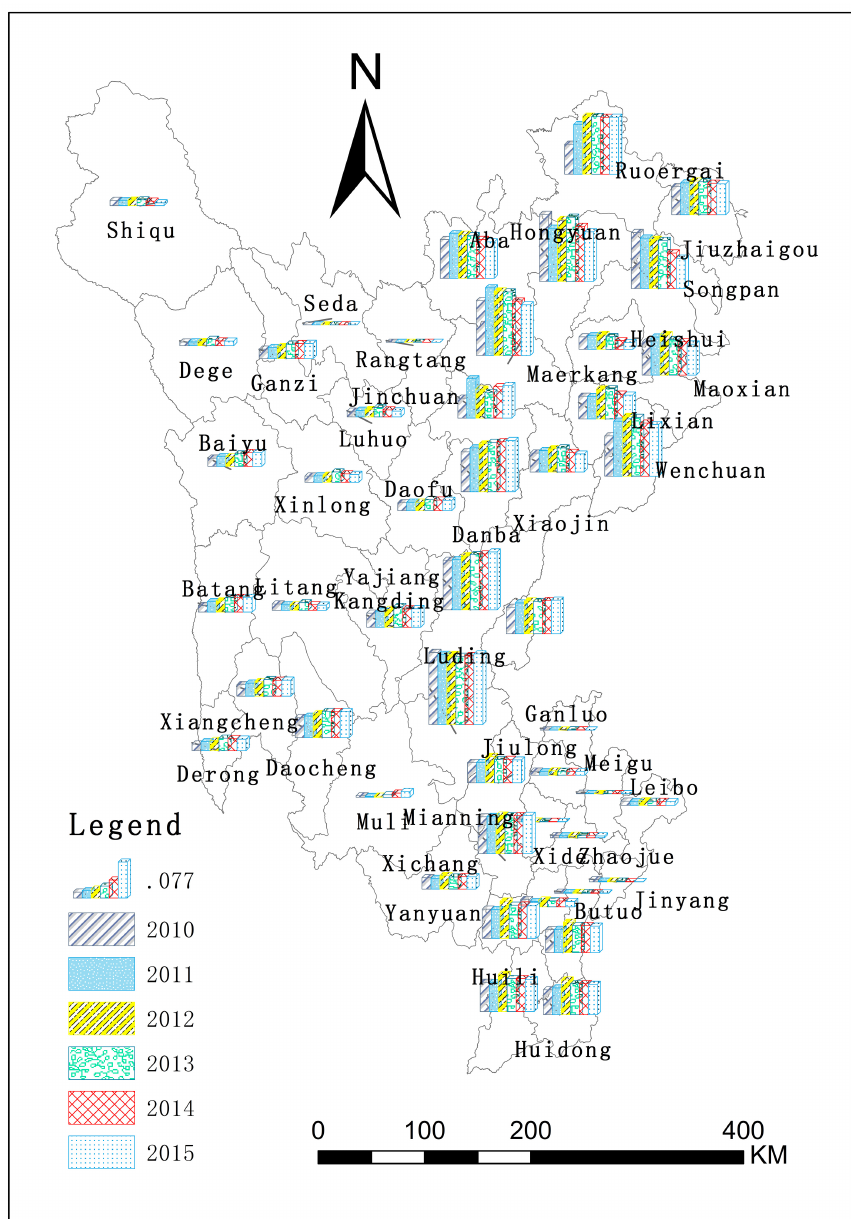
Figure 6. Financial capital